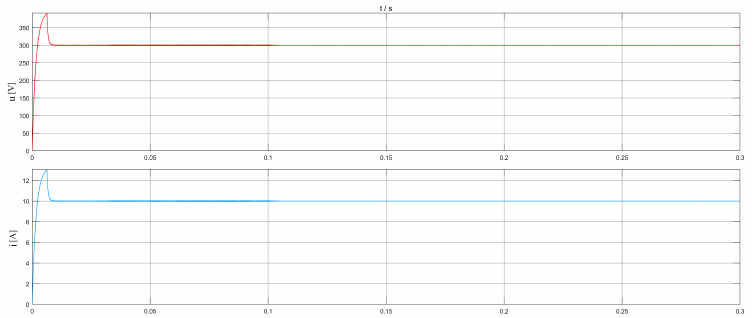
Figure 9. Output voltage and current waveform diagram of resistive load.